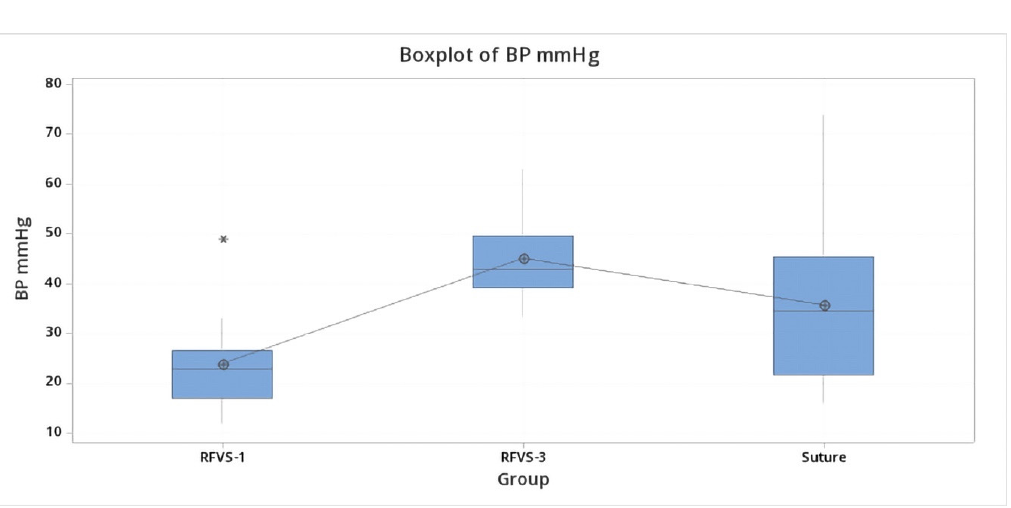
Figure 10. Boxplot of BP test. Mean maximum BP values for each group in Study arm 1. Group Suture; Group RFVS-1, LigaSure 5 mm Dolphin tip; Group RFVS-3, LigaSure Atlas 10 mm; BP, burst pressure). The group RFVS-1 resulted in significantly lower BP values ( p < 0.05). Otherwise, RFVS-3 and the Suture group showed comparable BP pressures ( p > 0.05). *: Outlier.